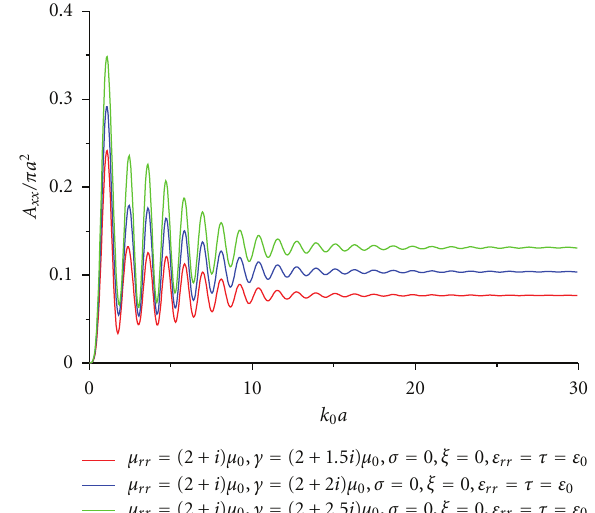
Figure 6: Normalized backscattering values versus sphere radius. Lossy negative anisotropic influence is considered. Here, the imaginary part for the permeability is bigger than 1.